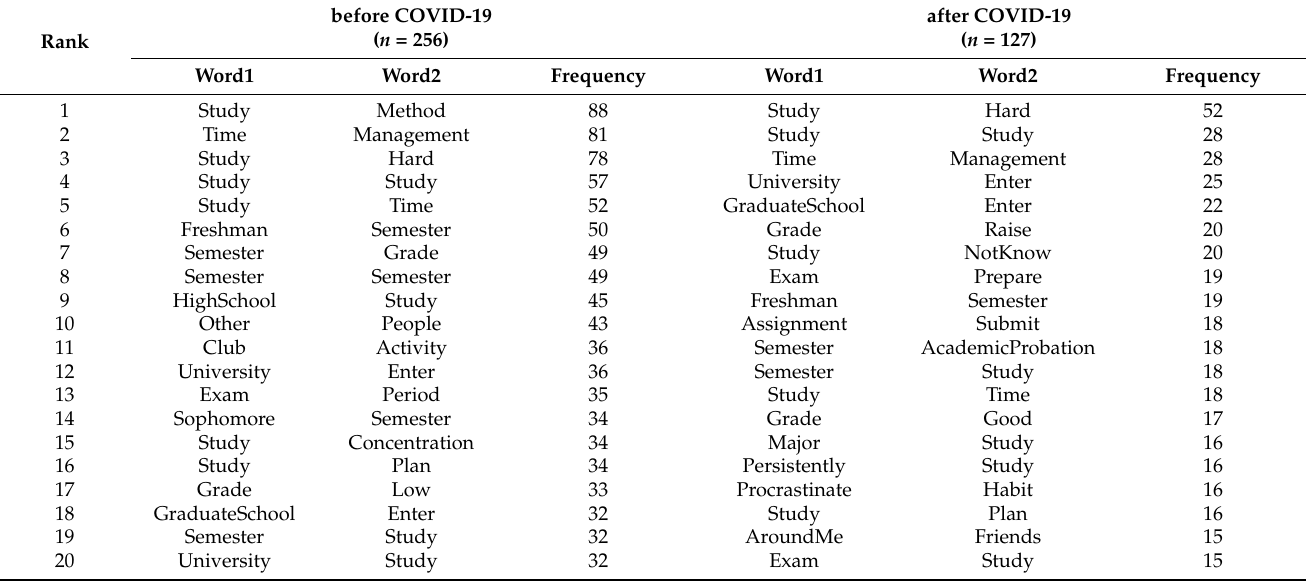
Table 6. Bigram of word relations before and after